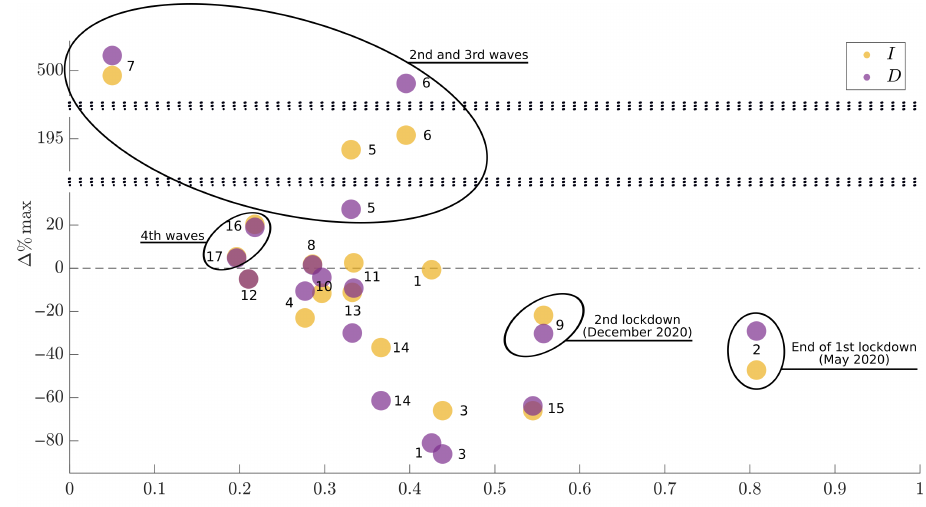
Figure 8. Percentage variation between two successive months of the maximum values of infected (yellow) and dead (violet) individuals versus e ( t ) . The labels indicate the reference months with respect to which the percentage variation is calculated, for example, 1 refers to the percentage variation between March and April 2020 and 17 to the percentage variation between August and September 2021. Regarding the variable D , since the model considers the total amount of dead people in each time instant, we have differentiated the variable in order to have the effective daily number of deaths. The clusters highlight crucial situations in the overall period of the pandemic indicated in the corresponding